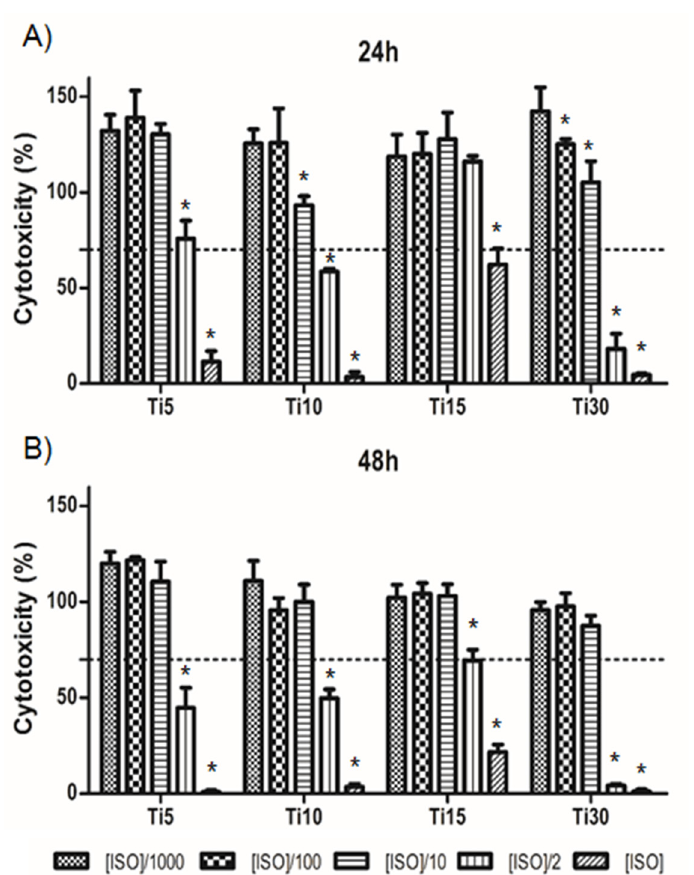
Figure 3. Cytotoxicity levels for THP-1. Cells cultured with titanium microparticle extracts at 5 μ m, 10 μ m, 15 μ m, and 30 μ m, performed at 24 h ( A ) and 48 h ( B ). Cells were cultured at ISO concentrations of 0.2 g/mL and its dilutions. * p < 0.05 vs. ISO/1000.